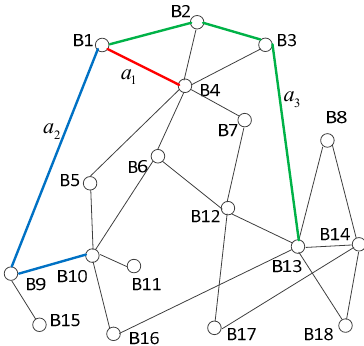
Figure 2. An example system with 18 substations and 27 channels, which can be used to explain the minimum hops sum, the link degree sum, and the primary substation selection model.